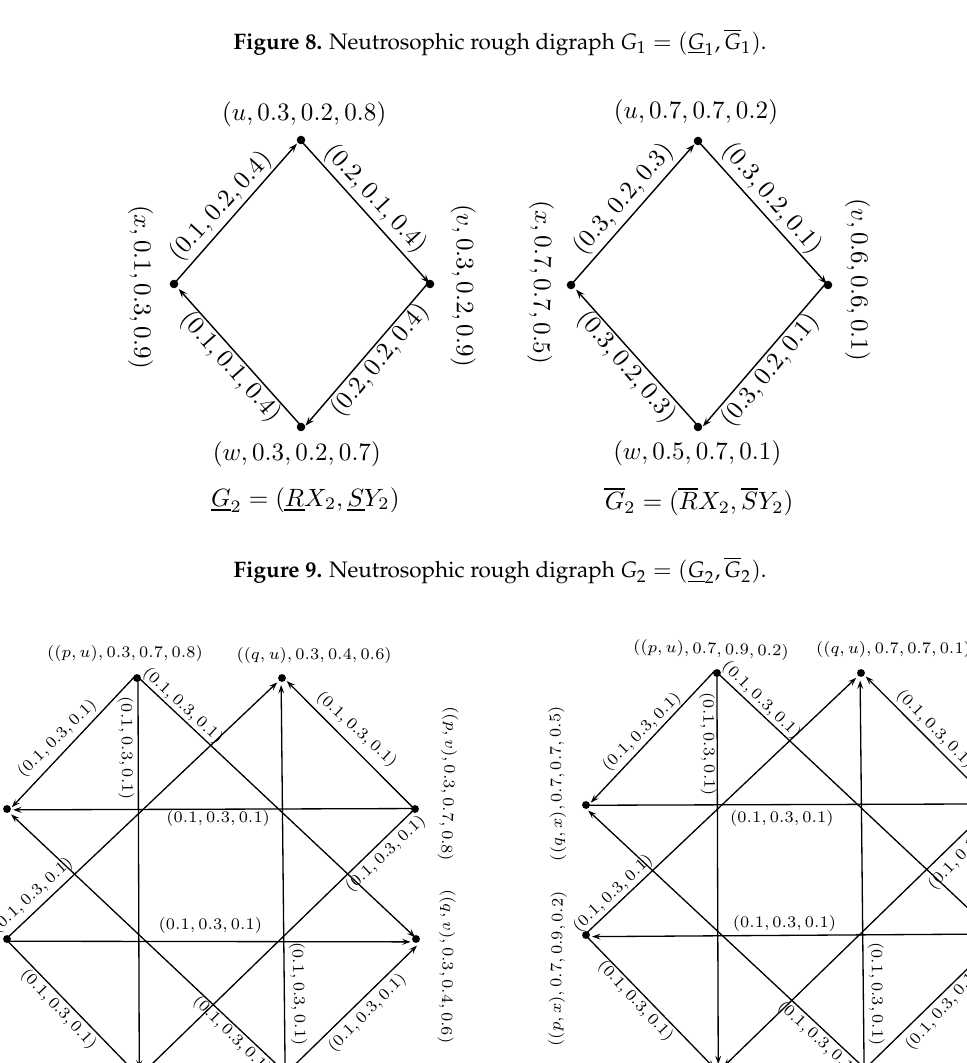
Figure 10: Neutrosophic Rough Digraph G = ( G